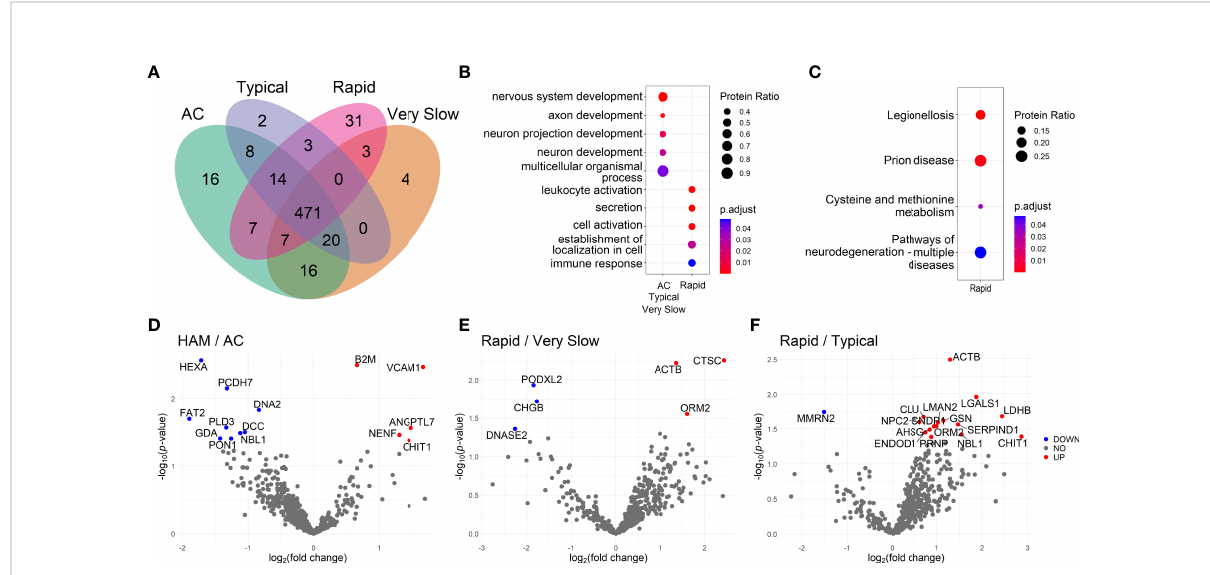
FIGURE 1 Investigation of the cerebrospinal fl uid proteome of HTLV-1-infected individuals. (A) Venn diagram shows the number of proteins identi fi ed by LC-MS/MS in samples from patients separated as HTLV-1 asymptomatic carriers (AC) (n=13), and HAM/TSP patients with very slow (n=6), typical (n=7), and rapid (n=6) disease progression. Functional enrichment analysis of protein sets was performed using the databases from (B) the Gene Ontology terms of biological processes and (C) the Kyoto Encyclopedia of Genes and Genomes (KEGG). The size of the dots is proportional to the number of proteins enriched in the process/pathway, and the color gradient indicates the adjusted p -values. (D – F) Differential protein expression between groups according to the neurological condition is presented in Volcano plots showing uncorrected -log 10 -transformed p -values and the log 2 -transformed fold change of common proteins between the two groups. Proteins differentially expressed with log 2 - transformed fold change higher than 0.6 and lower than -0.6 and were considered upregulated (red dots) and downregulated (blue dots), respectively. The statistical analysis was performed with the Student ’ s t -test. Differences with -log 10 -transformed p -value higher than 1.3 were considered signi fi